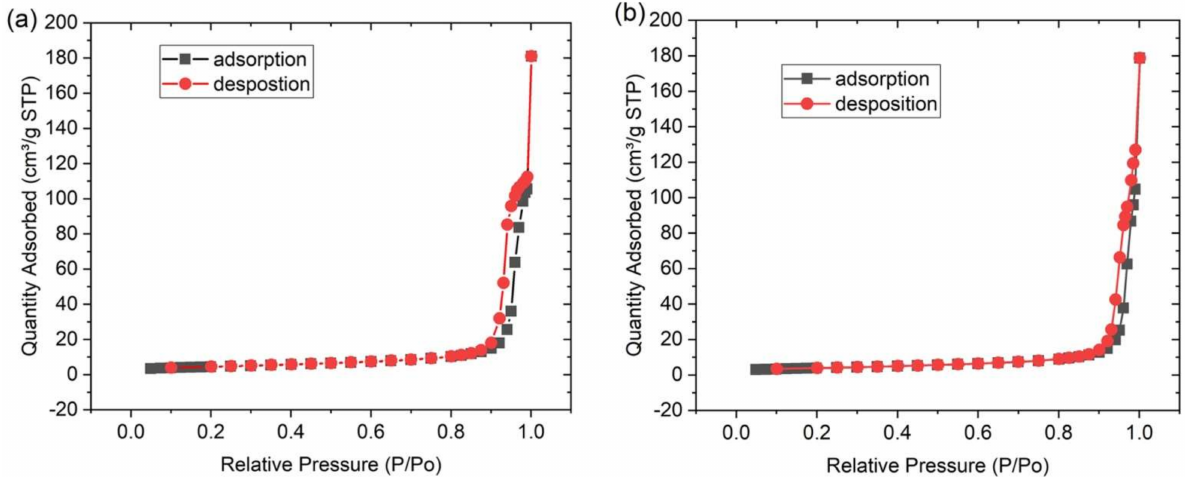
Figure 5. Nitrogen adsorption-desorption isotherms of ( a ) ZrO 2 /CuO, and ( b ) 2 mol% Ce 3+ /Ce 4+ - doped ZrO 2 /CuO.